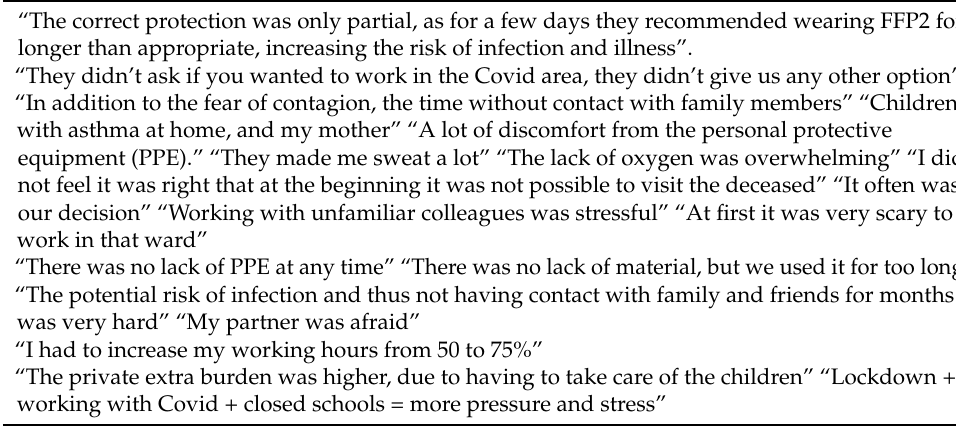
Table 3. Selected comments from the Stress Scale.